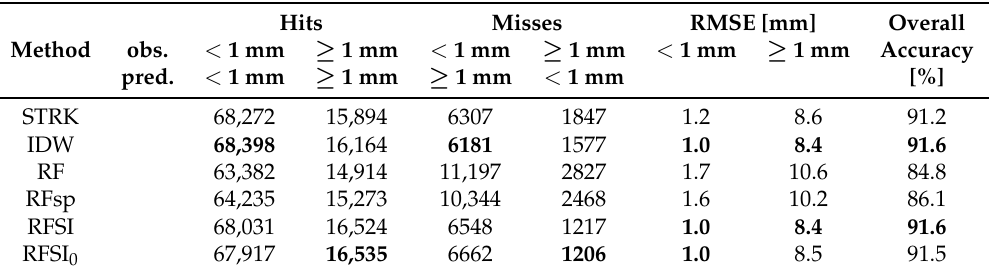
Table 5. Performance of all models for precipitation below and above 1 mm. Values for the hits and misses are number of observations (obs.) for a given condition. Predictions (pred.) used in this table are from nested 5-fold LLOCV. Overall accuracy represents the percentage of correct classifications. Numbers in bold represent the best performance.